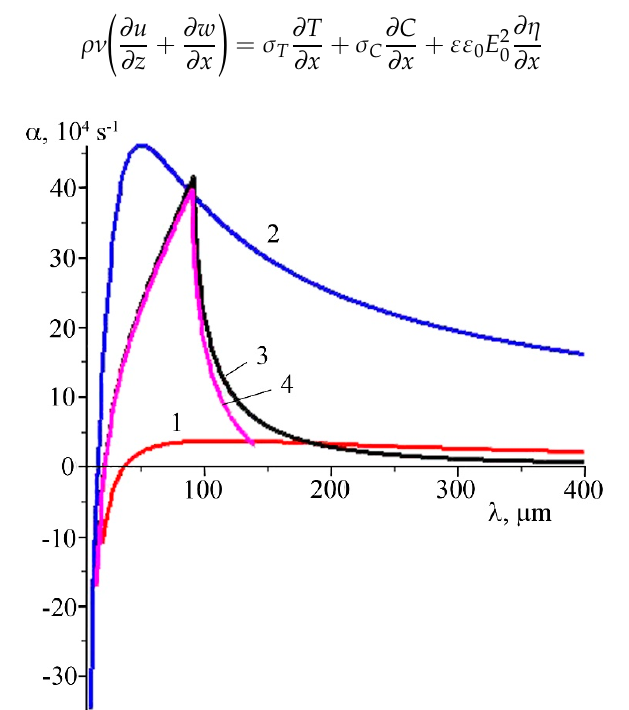
Figure 3. A growth rate characteristic of perturbations on the plasma–titanium melt interface found when solving the Equation (11): ( 1 ) ignoring thermoelectric and evaporation and capillary effects, ( 2 ) including the thermoelectric effect only, ( 3 ) with regard to thermal and evaporation and capillary instabilities, ( 4 ) involving thermal, evaporation and capillarity instabilities and the thermoelectric effect.